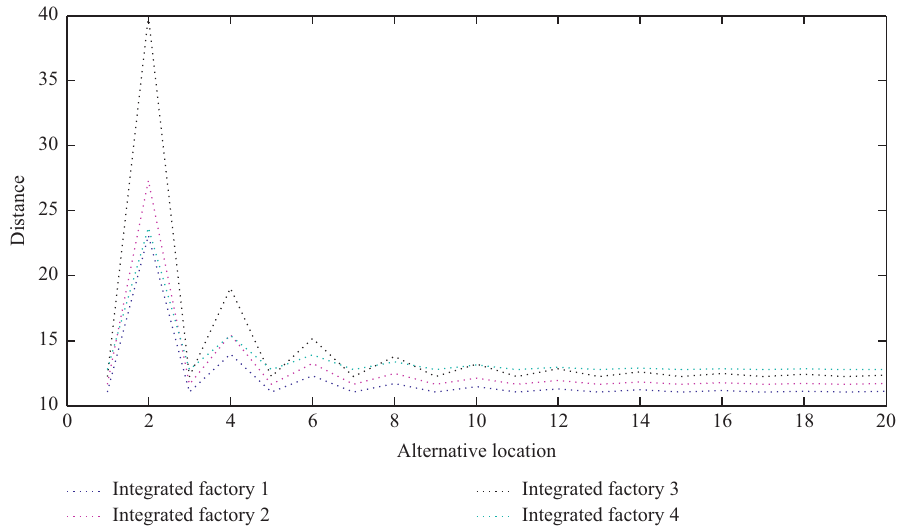
Figure 8: Distance from integrated factory to alternative location.